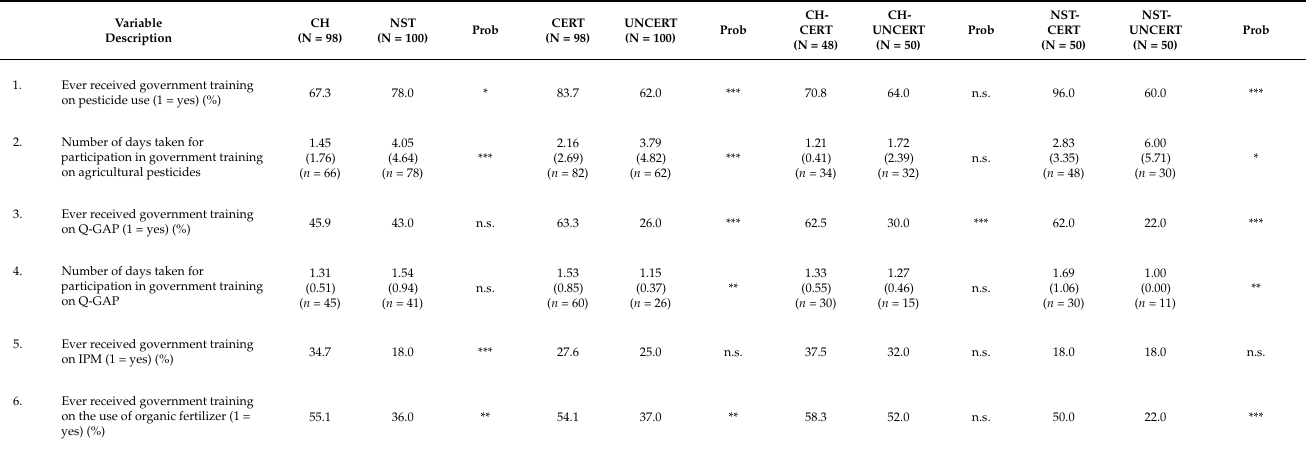
Table 6. Respondent farmers’ public training experiences related to GAP and the use of pesticides and organic fertilizer.